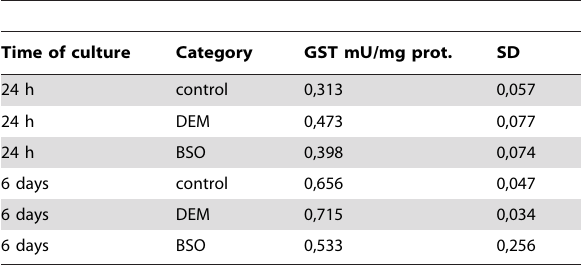
Table 1. Effect of glutathione depletion on Glutathione S- Transferase (GST) activity.